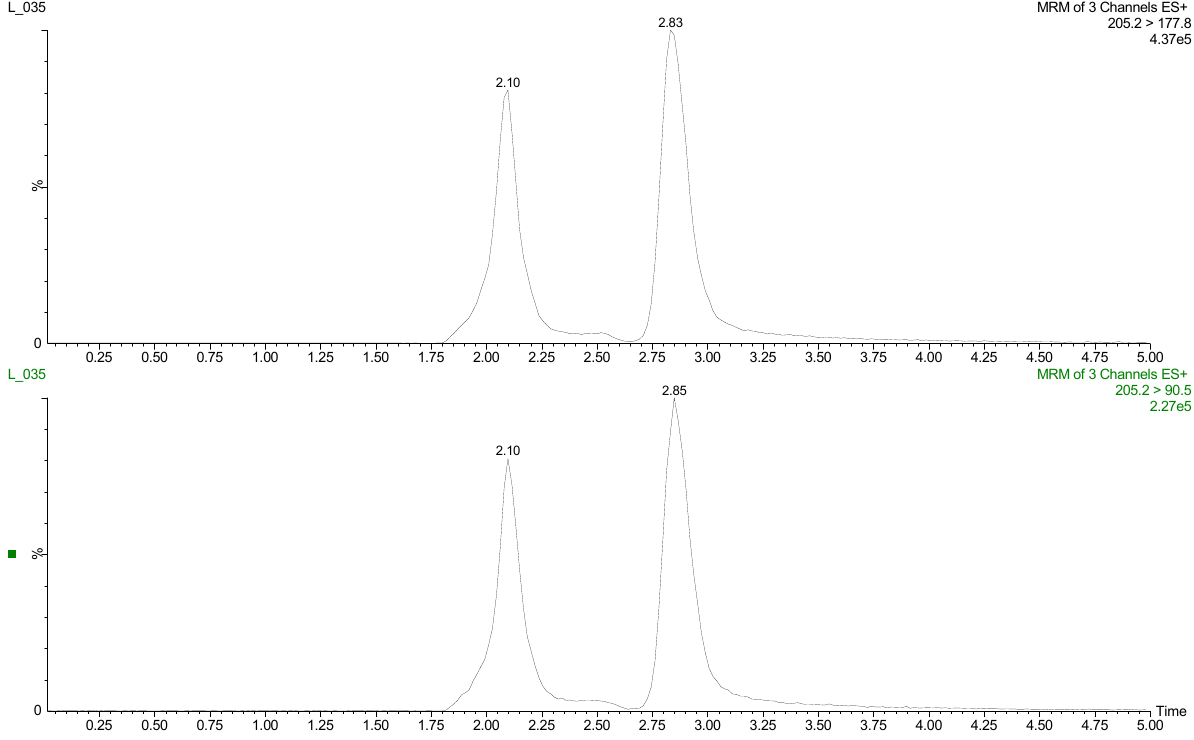
Figure A6. Chromatogram of the treated chicken liver sample 24 h after treatment.